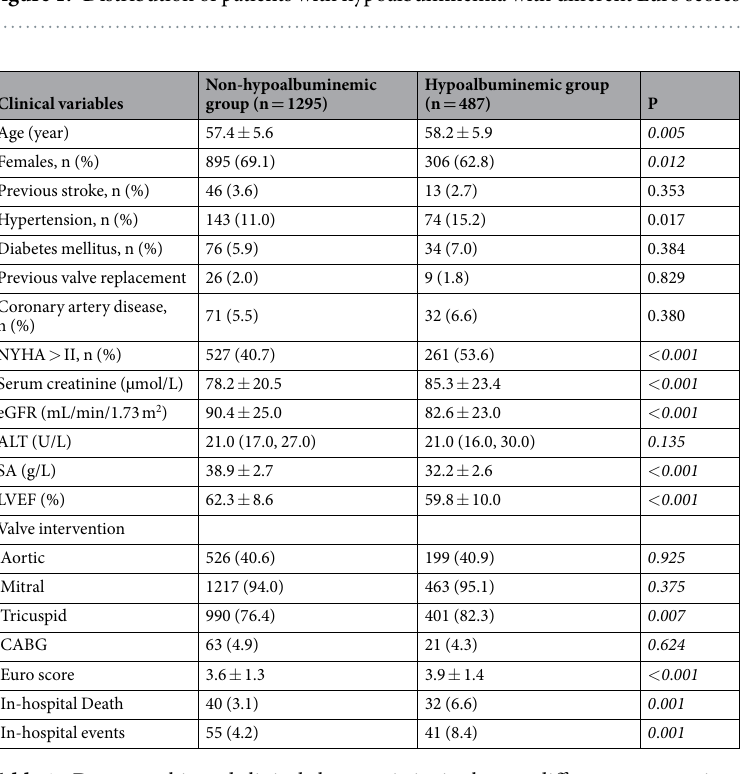
Figure 1. Distribution of patients with hypoalbuminemia with different Euro scores.